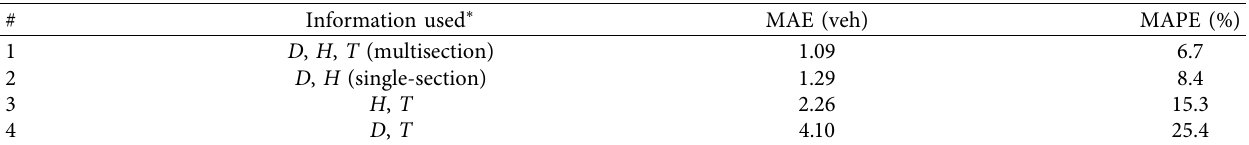
Figure 11: GMM results with multisection LPR Table 2: Estimation results under diferent information combination.